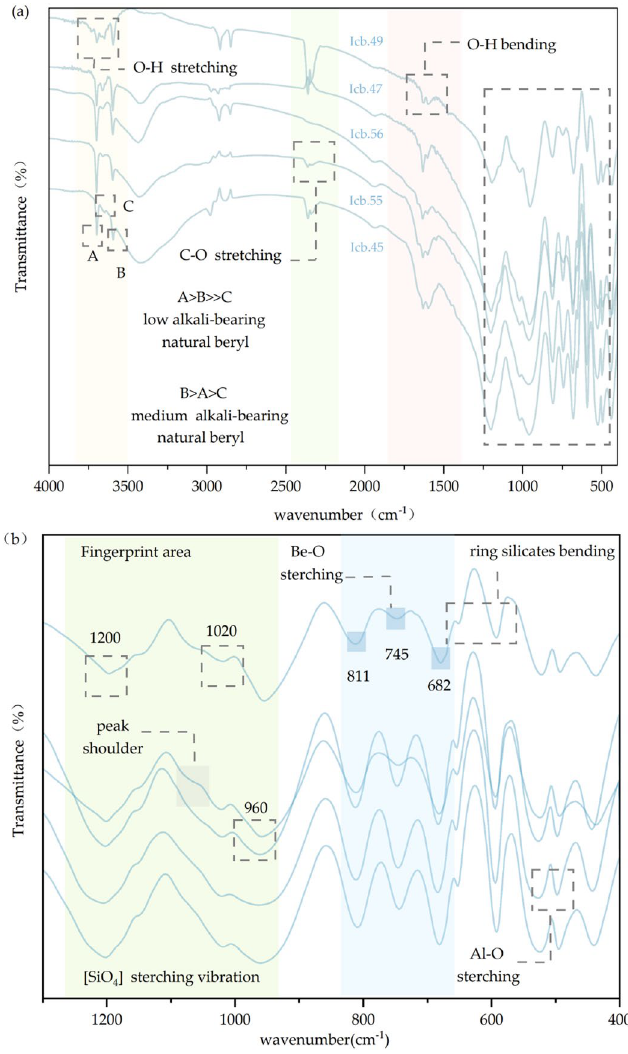
Figure 1. FTIR spectra of beryl. ( a ) 4000 cm −1 ~ 1300 cm −1 indicates samples are beryl with low to medium alkali content, the existence of carbon dioxide absorption peak proves that the samples are natural beryl. ( b ) Fingerprint region of infrared spectrum, which shows the characteristic absorptions of beryl. The spectra are displaced vertically for